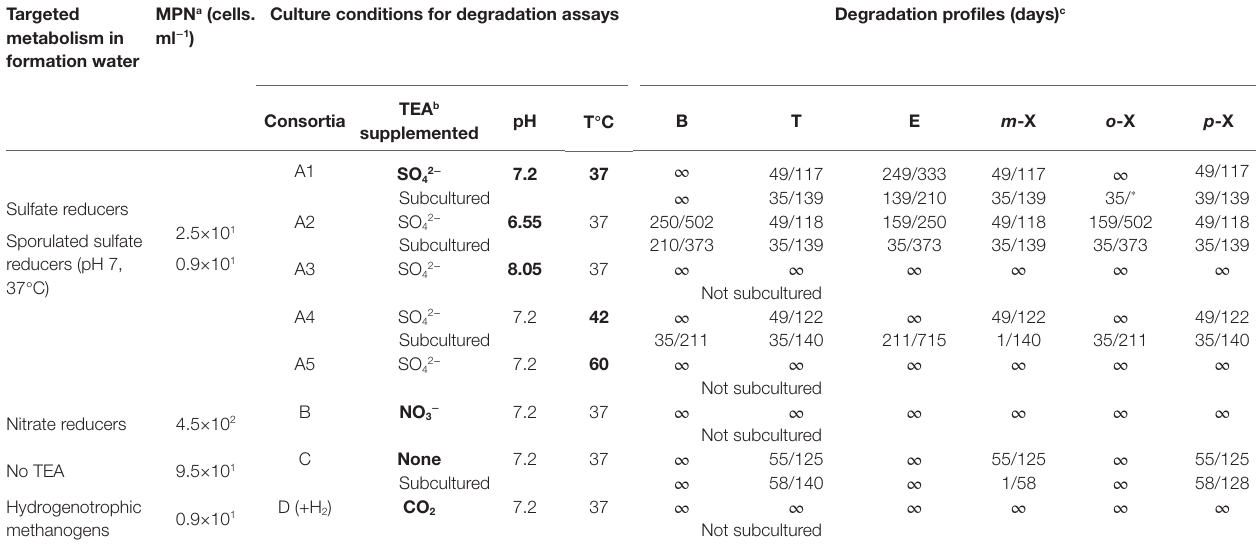
TABLE 2 | Results of metabolic group counts by MPN and BTEX degradation according to targeted metabolism. Targeted MPN a metabolism in formation water